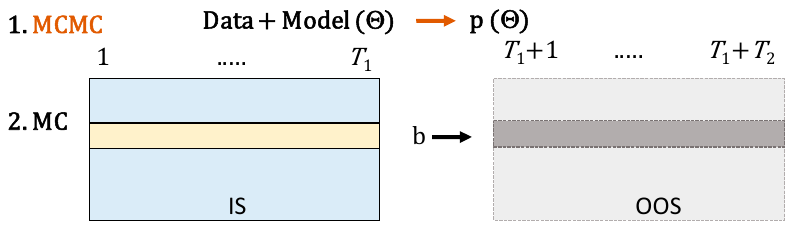
Figure 4. Two-step Bayesian simulation (Markov chain Monte Carlo (MCMC) parameter estimation and Monte Carlo (MC) data simulation).